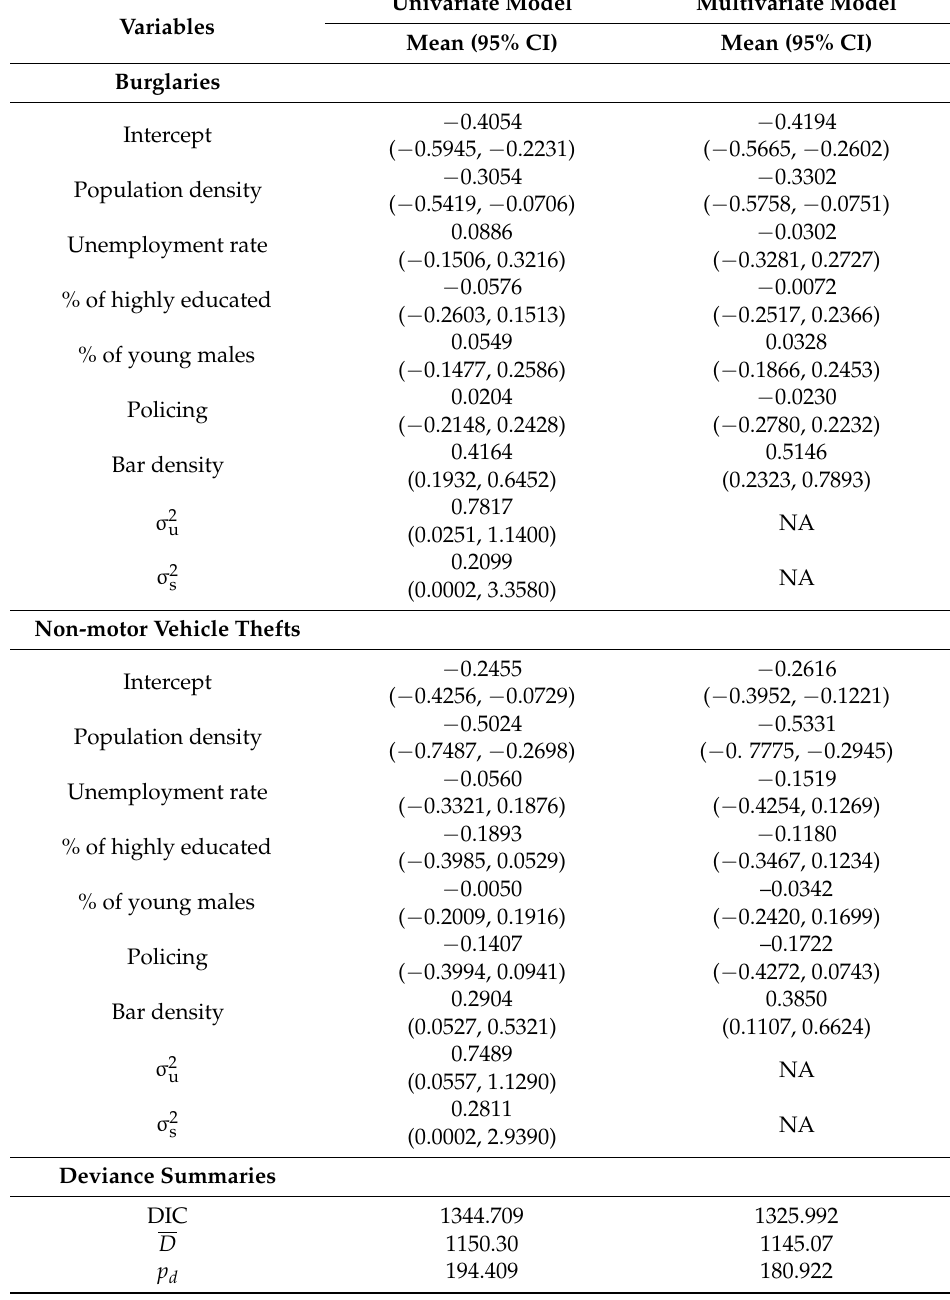
Table 3. Results of the univariate and the multivariate